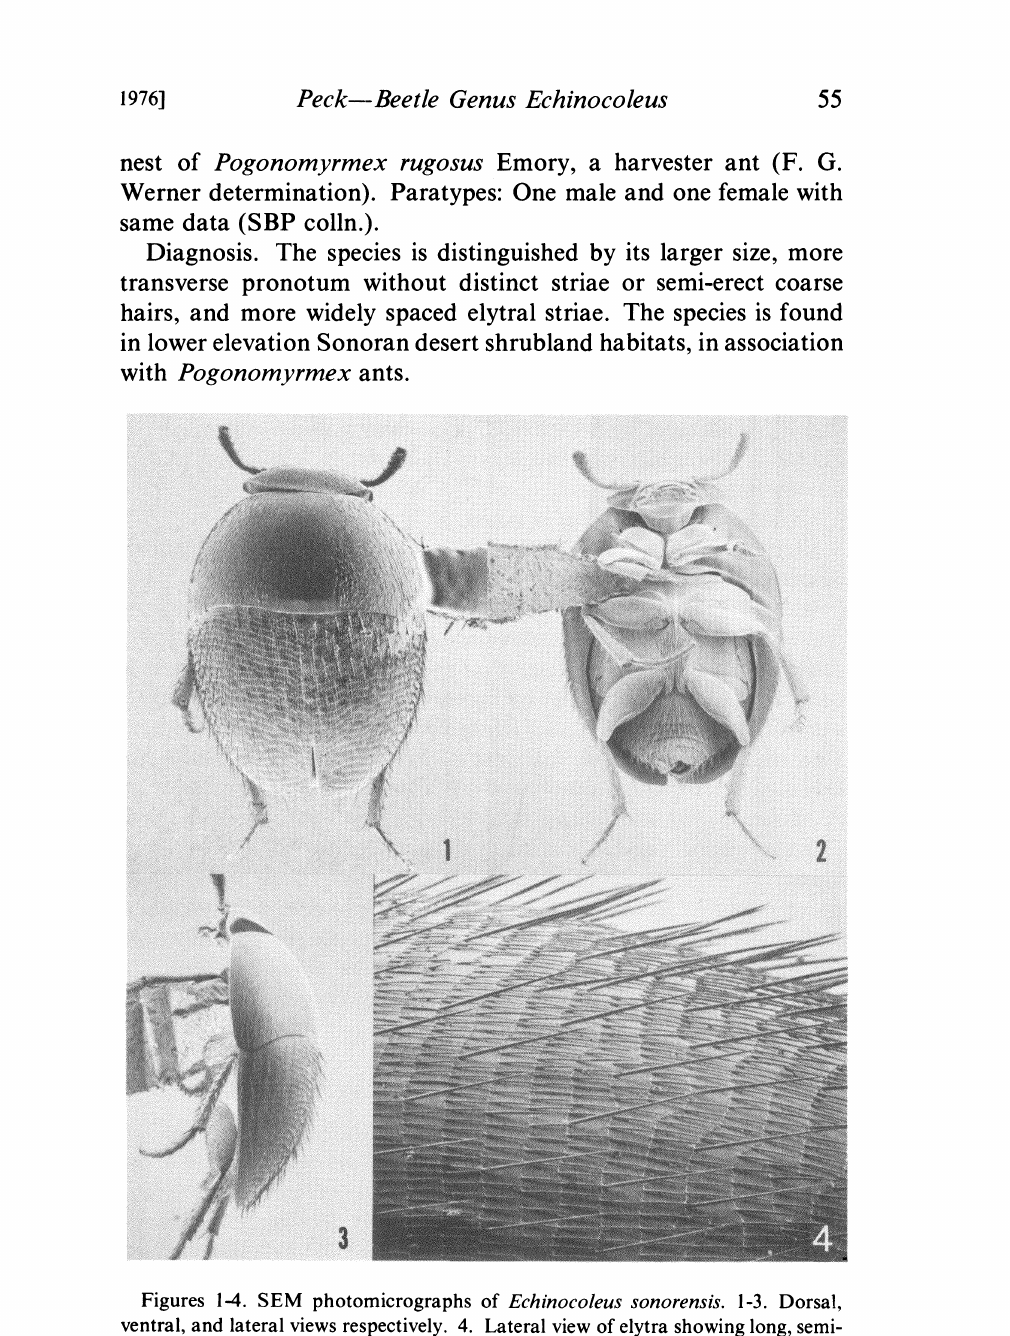
Figures 1-4. SEM photomicrographs of Echinocoleus sonorensis. 1-3. Dorsal, ventral, and lateral views respectively. 4. Lateral view of elytra showing long, semi- erect